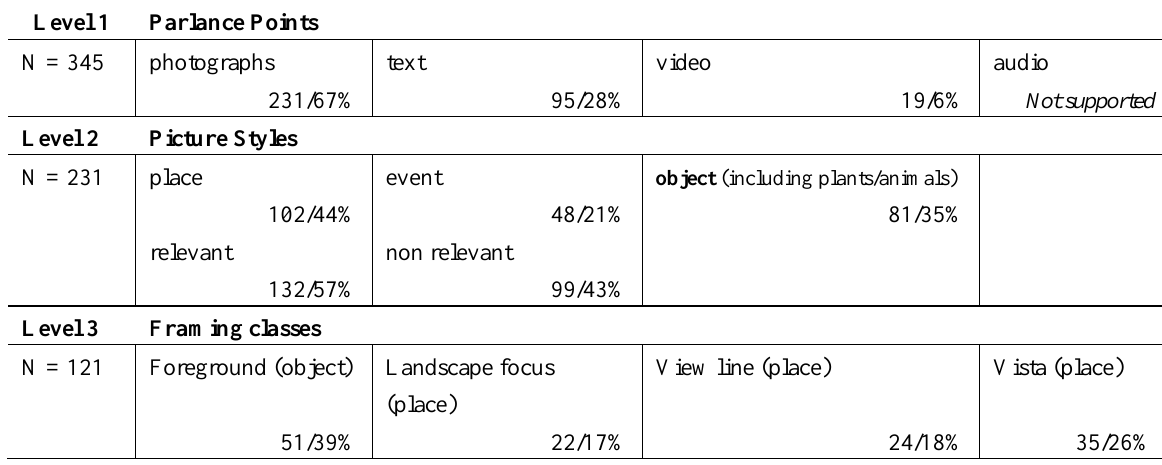
Table 3. Parlance points